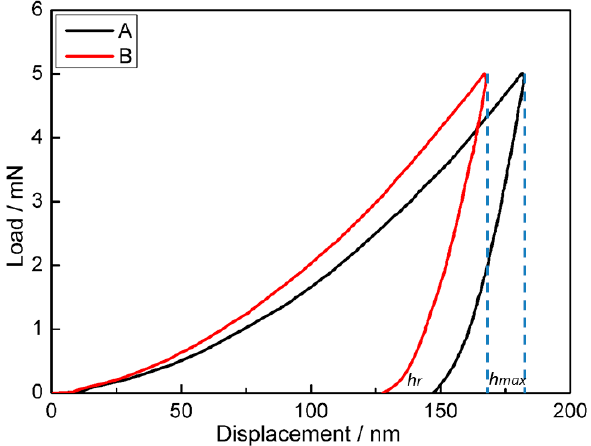
Figure 5. Load-displacement curves of the alloy coating A and B.